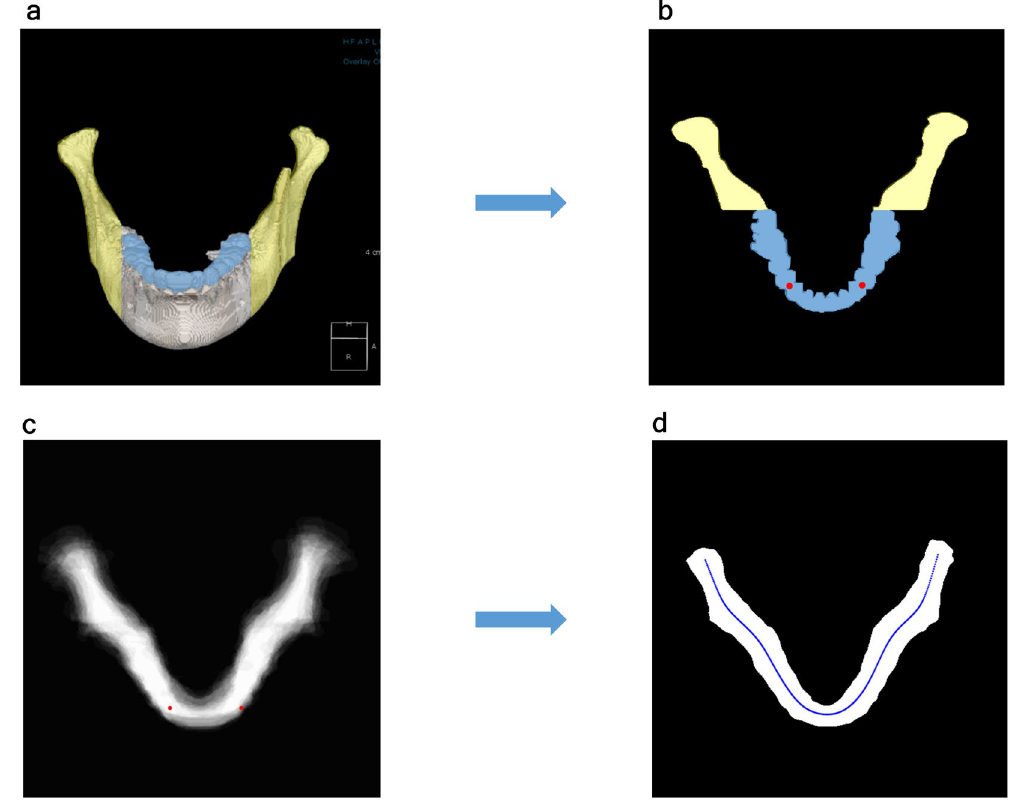
Figure 6. The process of obtaining the average arch model using the segmented 3D image. ( a ) Segmented 3D mandible. ( b ) Axial MIP image created by selecting the dental arch and the posterior mandible containing the ramus and condyle in the segmented 3D image. The yellow area represents the ramus and condyle, whereas the blue area represents the dental arch. ( c ) Thirty MIP images were superimposed on the center of the bilateral distal contact points of the canines (red points). ( d ) The added images were binarized using a threshold value of 0.47 to obtain the average arch shape. A central line represents the center of the average arch shape. 3D, 3-dimensional; MIP, maximum intensity